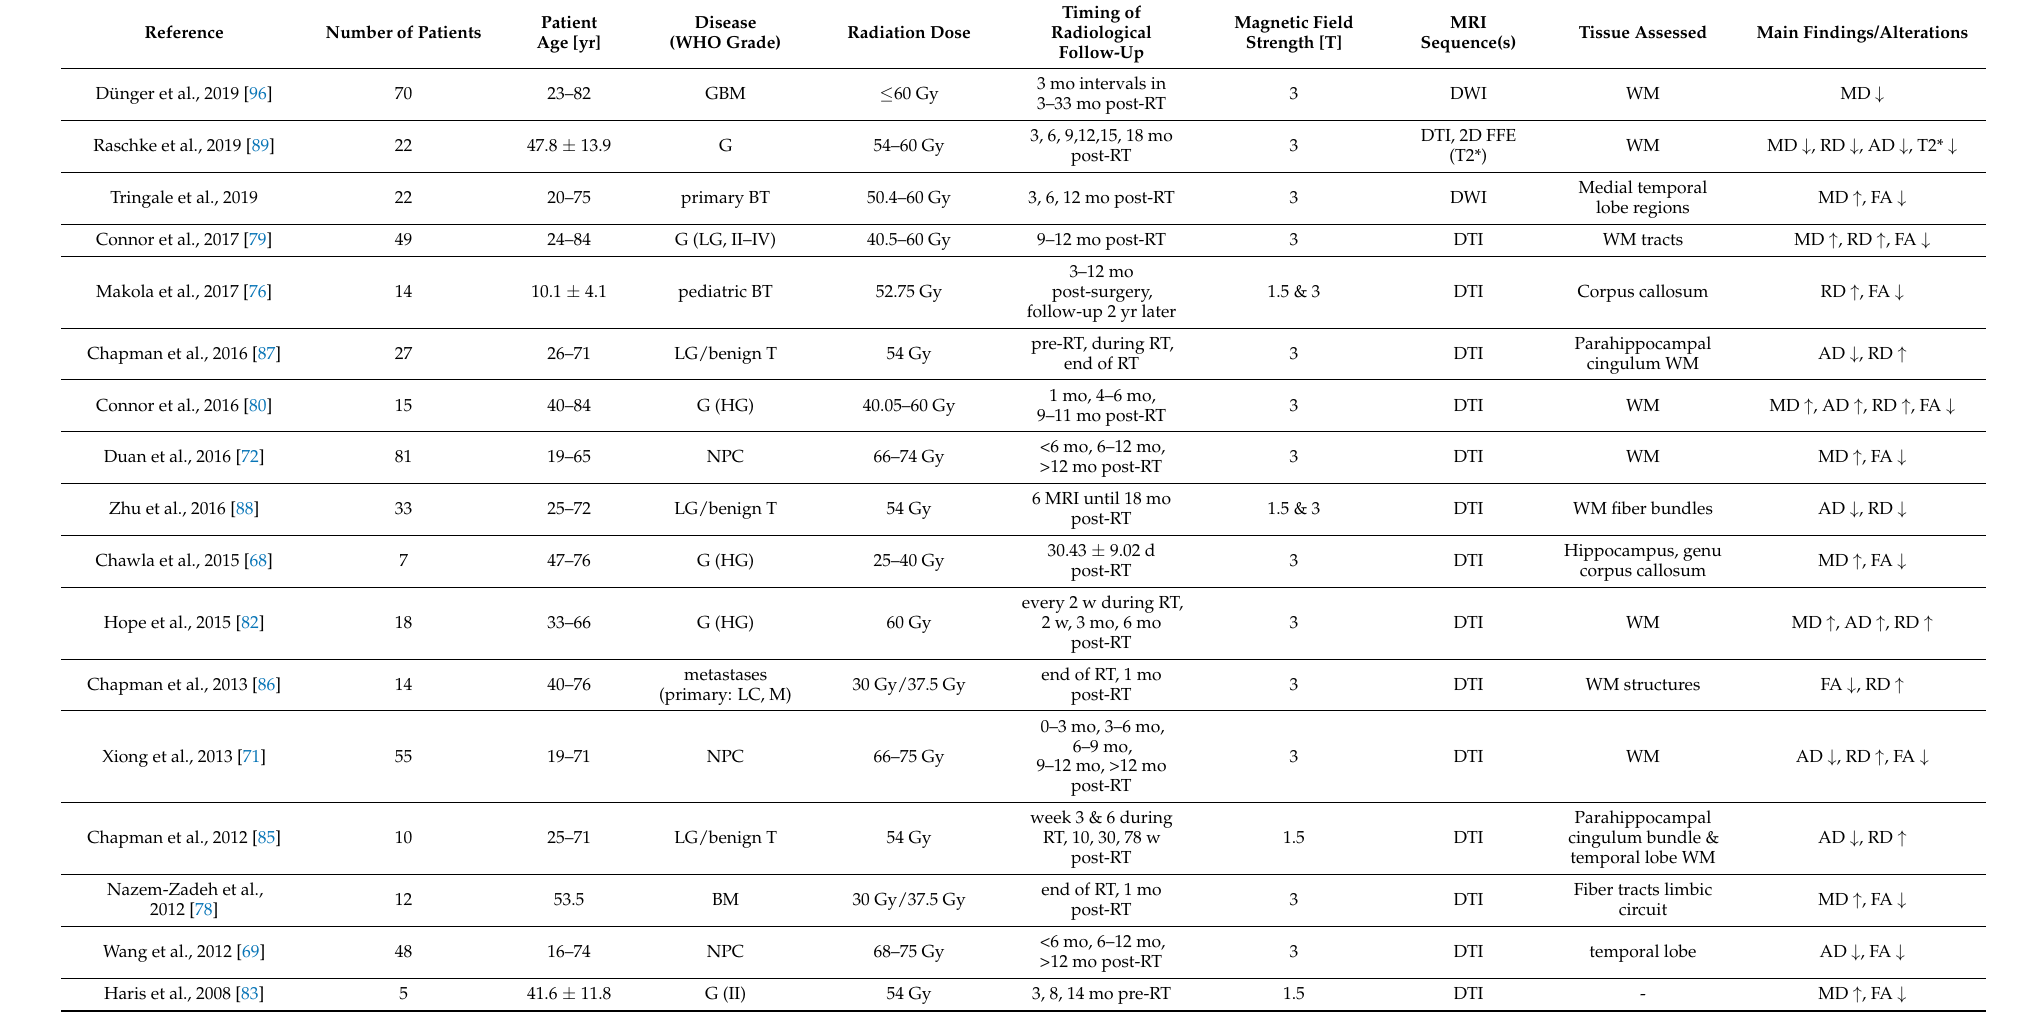
Table 2. Publications on microstructural changes in normal-appearing tissue after